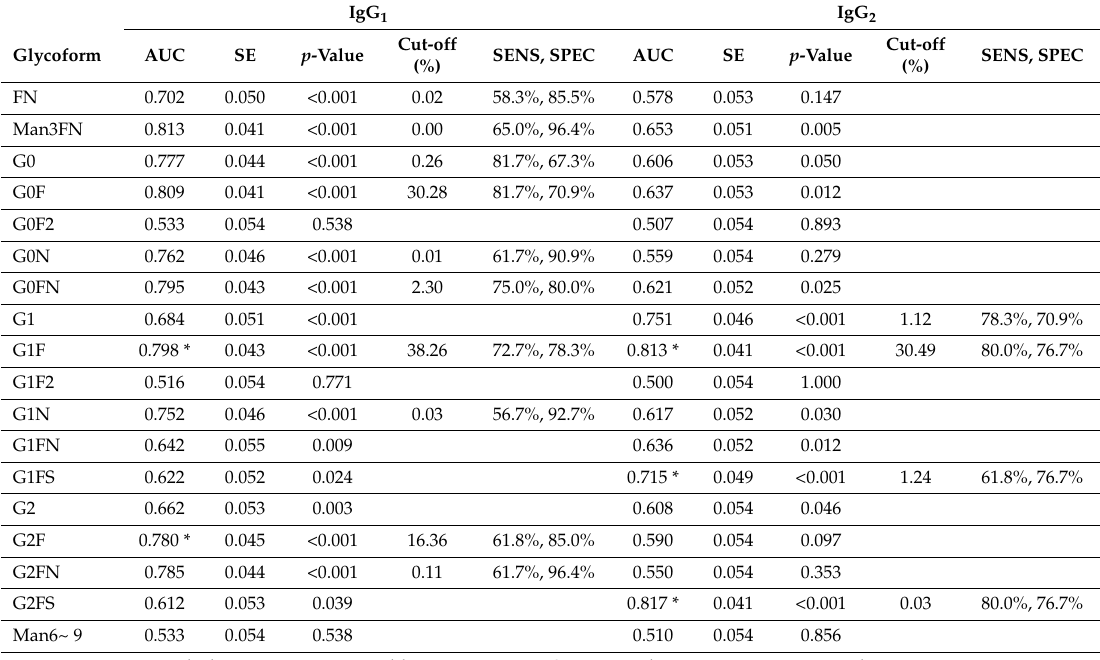
Table 3. Differentiation of cholangiocarcinoma by IgG 1 -Fc and IgG 2 -Fc N -glycoforms.